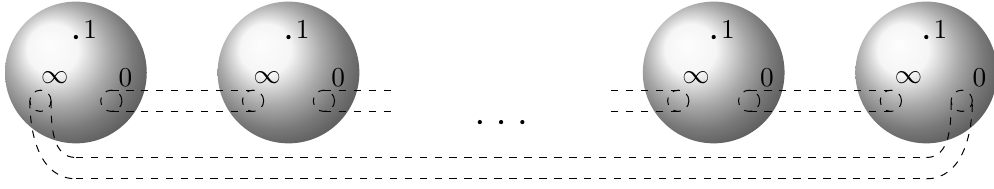
Figure 10 . The plumbing construction for the N -punctured